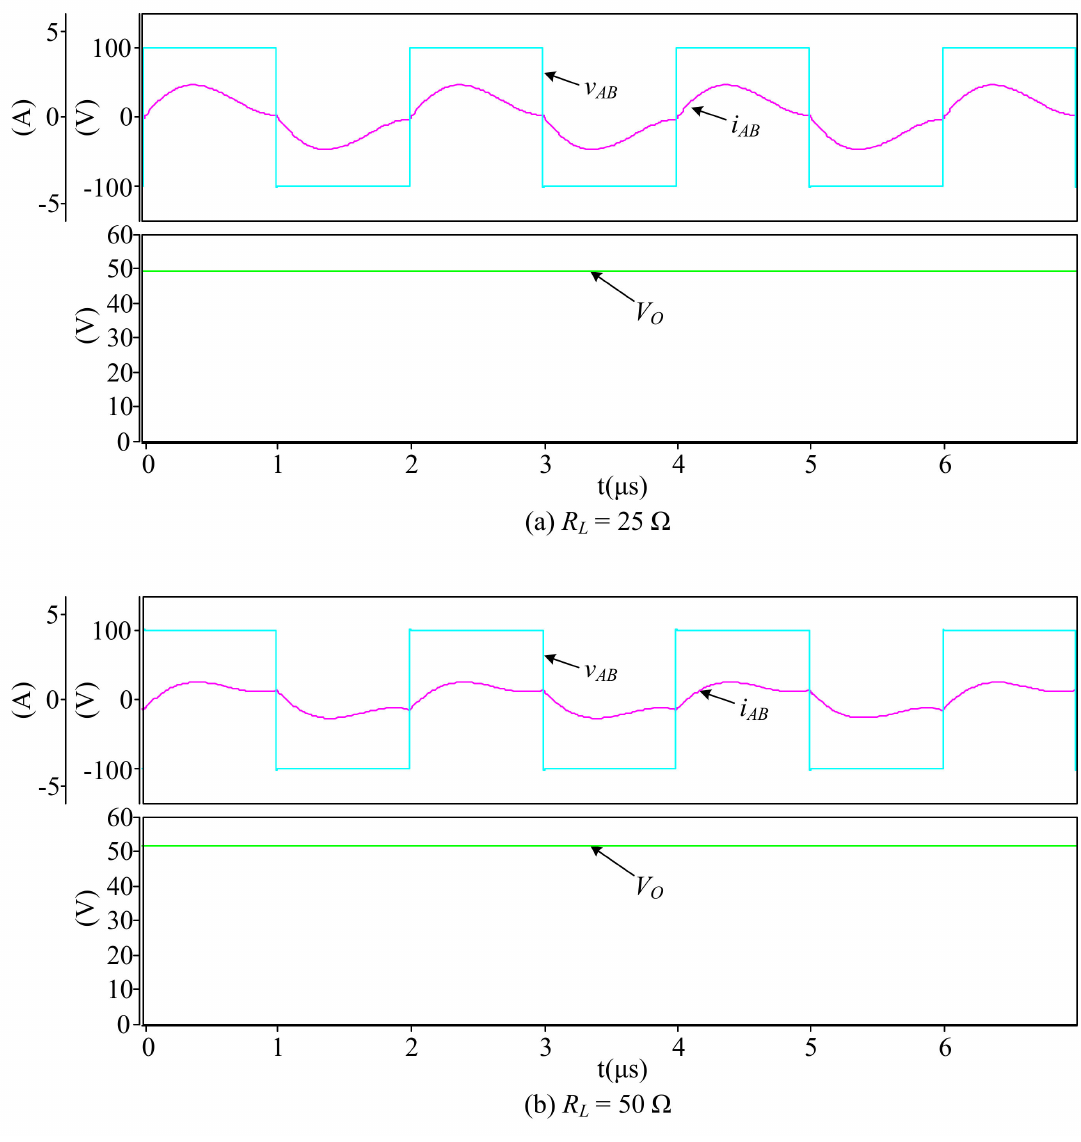
Figure 17. The waveforms of the L x − PS CPT circuit at CV